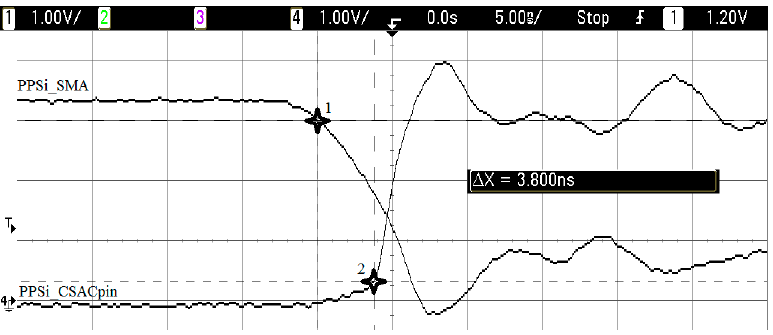
Figure 7. PPS i signals delay (example). The horizontal scale is one volt and the vertical scale is five nanoseconds per division, respectively. Table 3. Subsystems measured delays.